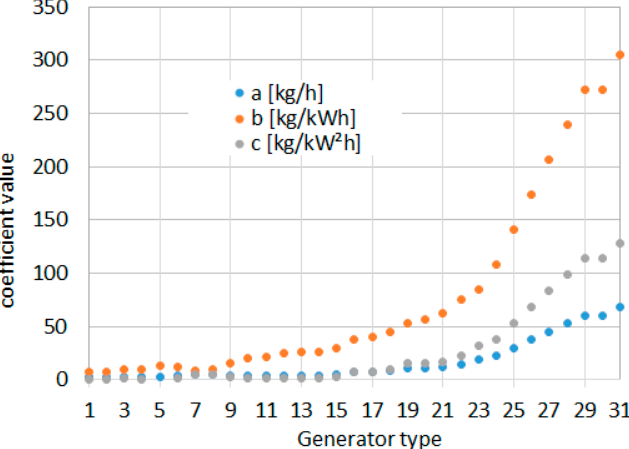
Figure 8. Fuel consumption coefficients.